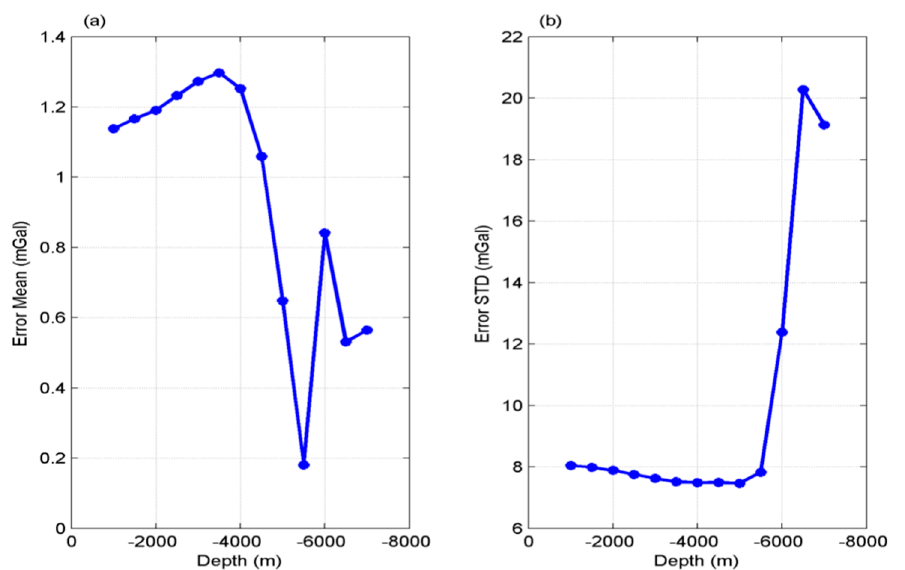
Figure 6. Accuracy at different depth of the water: ( a ) Error mean values; ( b ) error STD values.